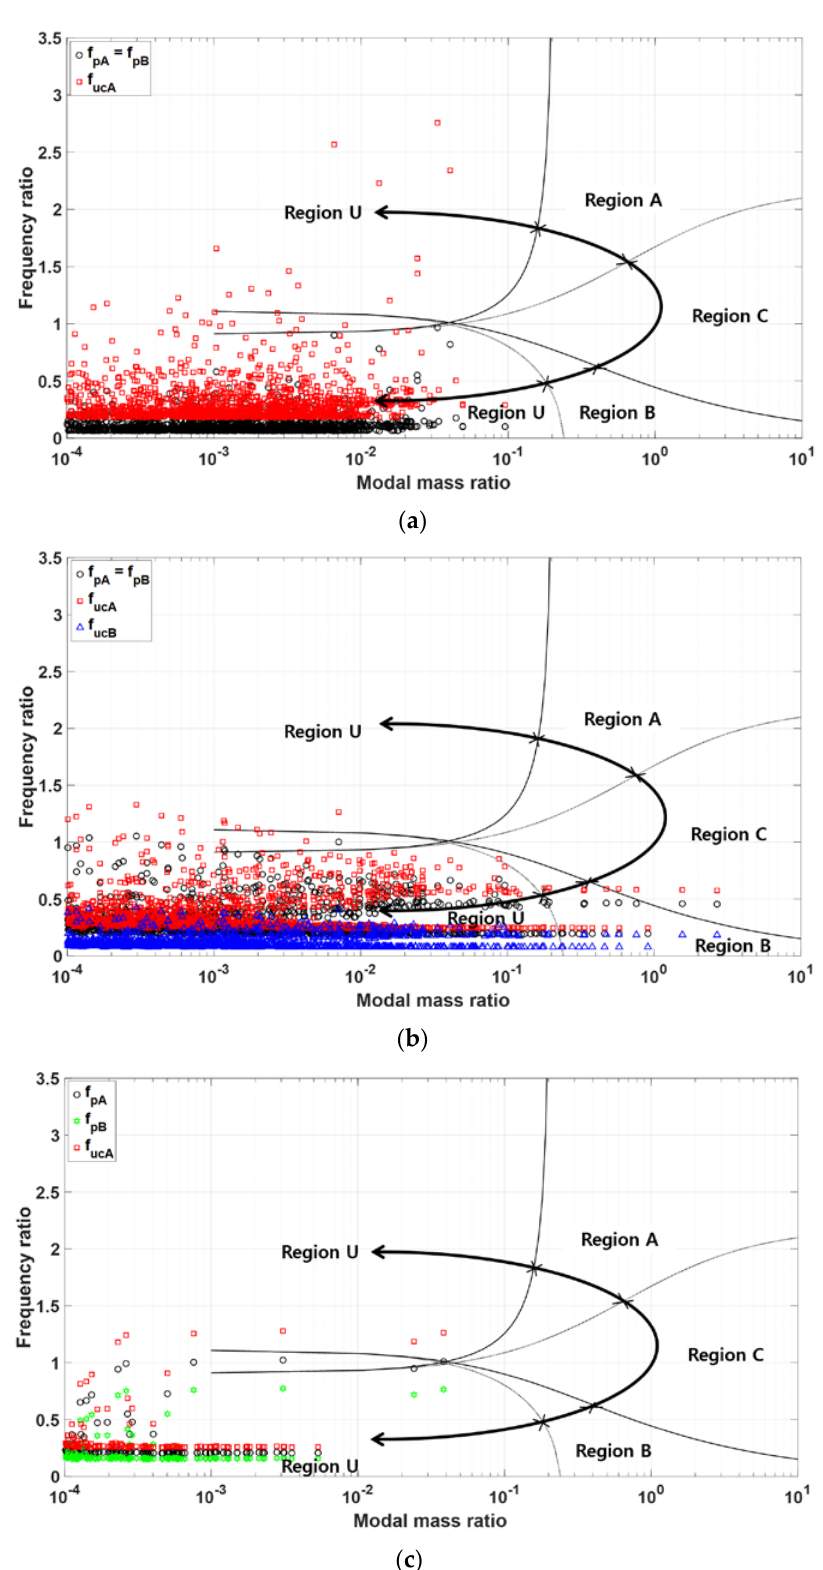
Figure 20. Application of Decoupled Analysis Criteria in ISRS (Model A): ( a ) Equipment Location 1; ( b ) Equipment Location 2; ( c ) Equipment Location 3.